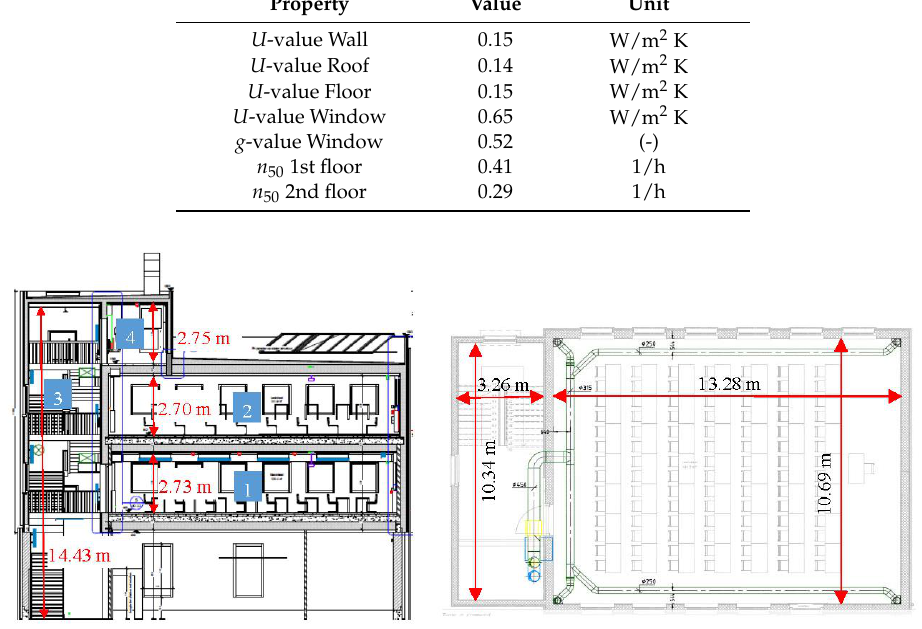
Figure 1. Section ( left ) and floor plan ( right ) of the test lecture rooms on Katholieke